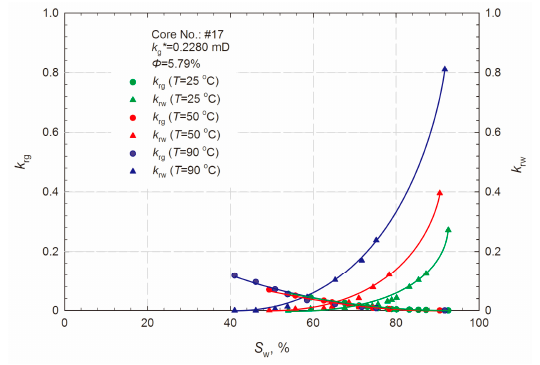
Figure 10. Effect of temperature on gas–water relative permeability.